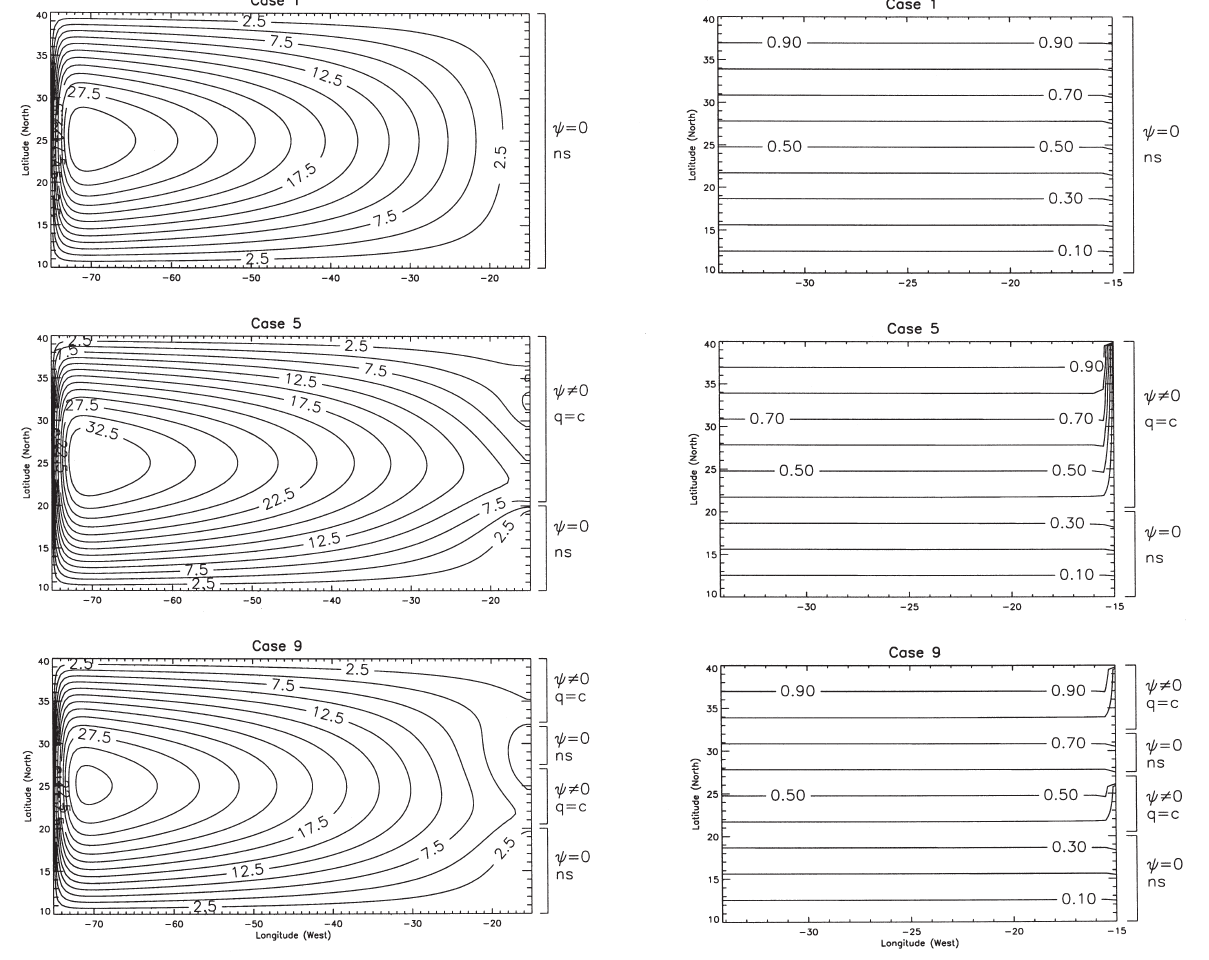
F IG . 2. – Integrated volume transport, with each flow line representing 2.5 Sv (ns: no-slip; q = c: constant potencial vorticity; ψ = 0: zero normal flux; ψ ≠ 0: non-zero normal